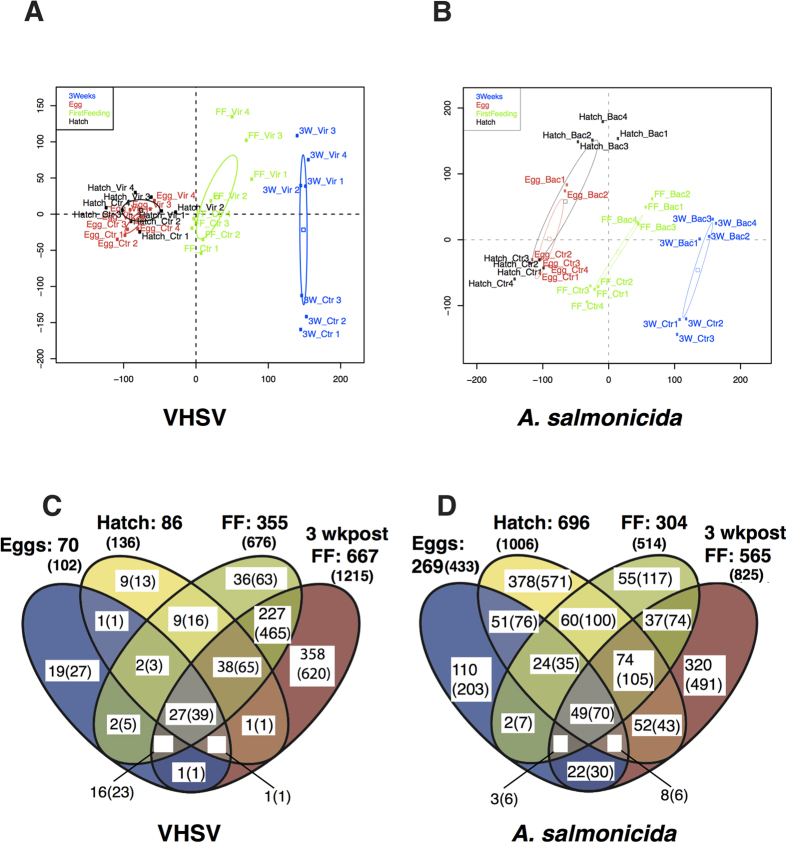
Global analysis of microarray data.(A) Principal component analysis of all features (except features deposited on the array for internal control) at four stages of development: eyed eggs “egg” in red; hatching “hatch” in black; first feeding “FF” in green and 3 weeks post first feeding “3w” in blue. Samples (pools of eggs or fry) are noted as either “vir” when infected by VHSV or “ctrl” for controls. Projection on the two first axis is shown (dimension 1: horizontal axis; dimension 2: vertical axis). (B) Similar principal component analysis of modulated features from samples infected by A. salmonicida, noted as “bac” or controls “ctrl”. (C,D) Venn diagrams showing the number of genes significantly up- or down- regulated at each stage of development (p < 0.01; Fold Change (FC) > 2 or <0.5) by VHSV or A. salmonicida. The corresponding numbers of array features are given in brackets.